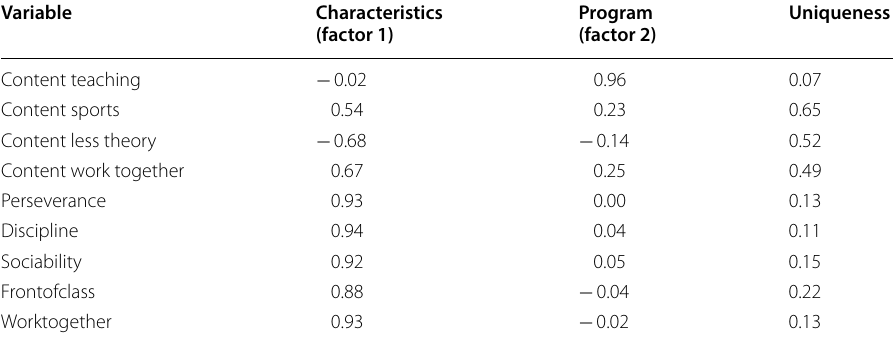
Table 9 The outcomes of the principal component analysis; the two columns indicate that 72% observed variation in content realism and characteristics realism can be explained by the two factors with an eigenvalue above the cutoff of 1.0 (χ 2 (36) 1570.98 p < 0.001; Cronbach’s alpha program content realism 0.91, Cronbach’s alpha characteristics realism 0.88) Factor 1 explains underlying variation in realism scores on the characteristics questions and Factor 2 explains variation in realism scores for program content questions Variable Characteristics Program (factor 1) (factor 2) Content